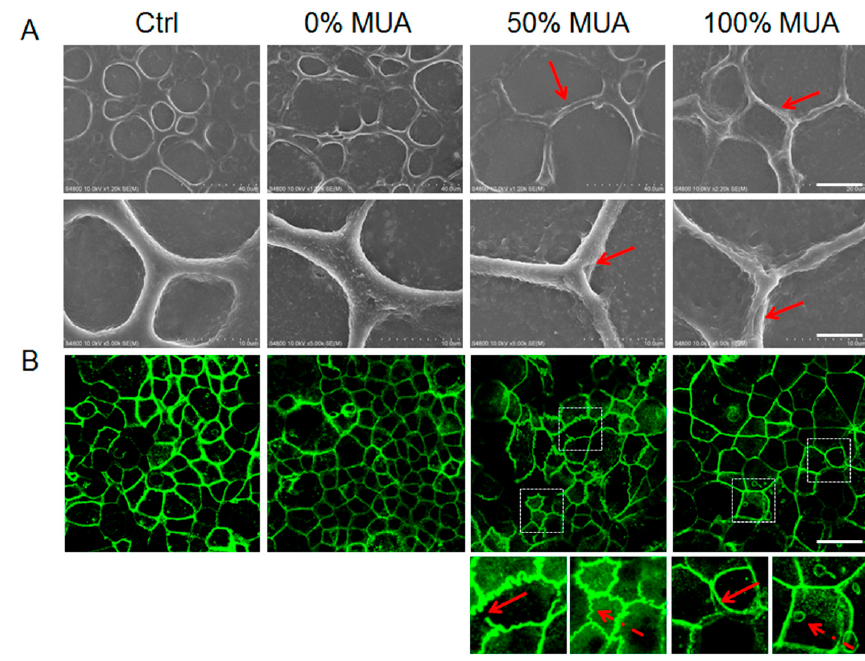
Figure 7. Disrupted tight junctions impacted by different surface-modified GNPs. ( A ) SEM images of cell monolayer surface structure. Upper line shows high coverage imaging, scale bar is 20 µ m. Lower line shows detailed imaging, scale bar is 5 µ m. Red arrows show tight junction details. ( B ) Immunofluorescence imaging of the ZO-1 protein in the Caco-2 cell monolayer and fluorescence intensity of ZO-1 distribution in the Caco-2 cells. Scale bar is 20 µm. Images with white dotted boxes are magnified, as shown under the images, and the red and red dotted arrows show the ZO-1 imaging details.